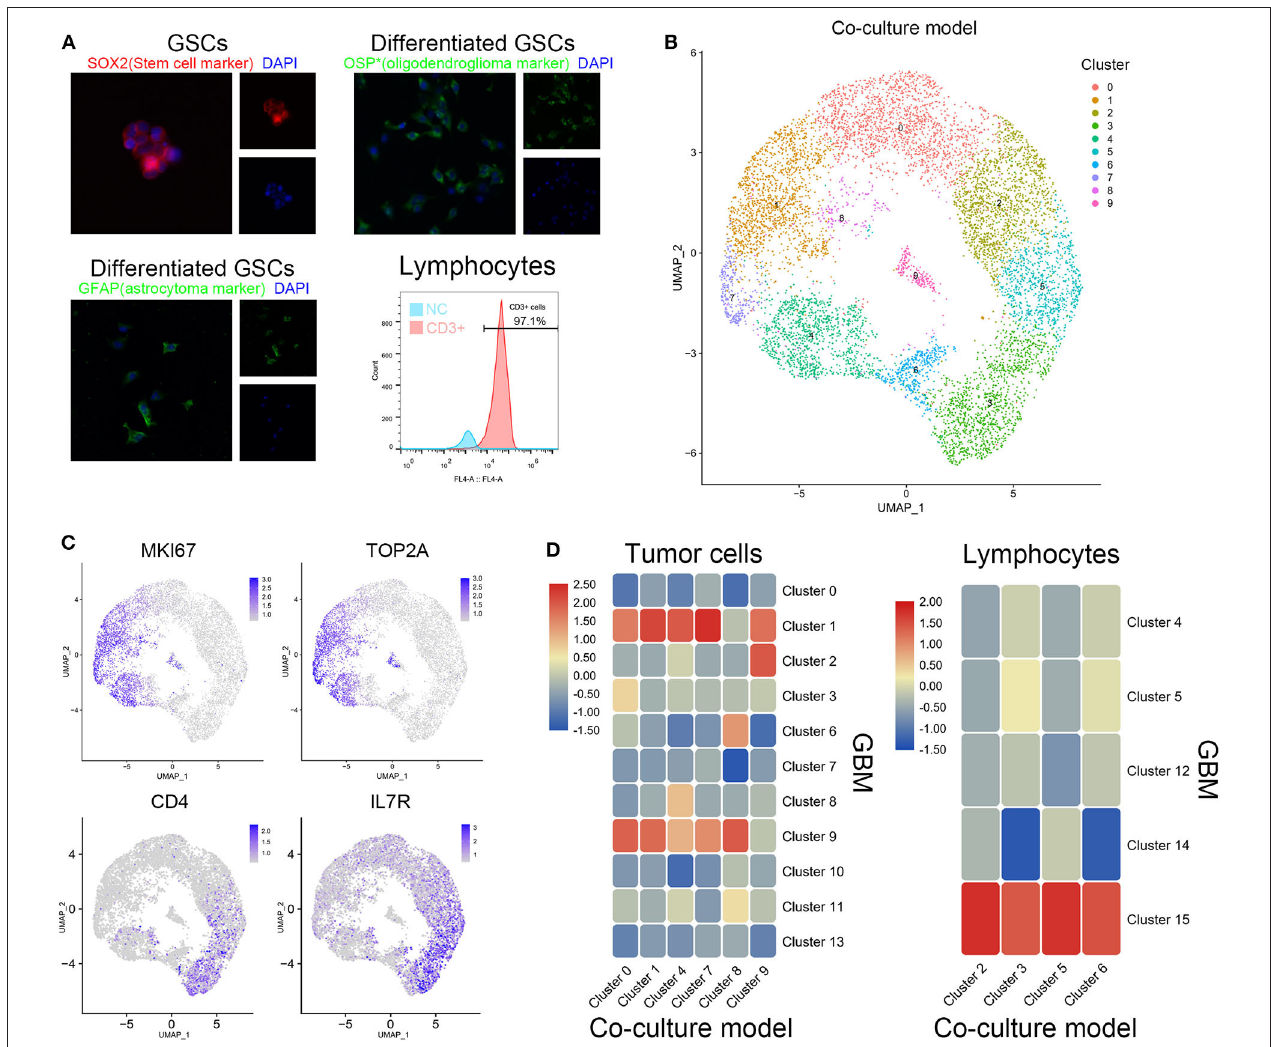
FIGURE 2 | Similarity of cell grouping in the coculture model and surgical specimens. (A) The GSCs and T cells were verified by immunofluorescence staining and flow cytometry. OSP: oligodendrocyte specific protein. (B) The subgroups of cells in the coculture model. (C) Markers of proliferation and immunology in different cell groups. (D) The similarity of glioma stem cells and lymphocytes in the coculture model and surgical